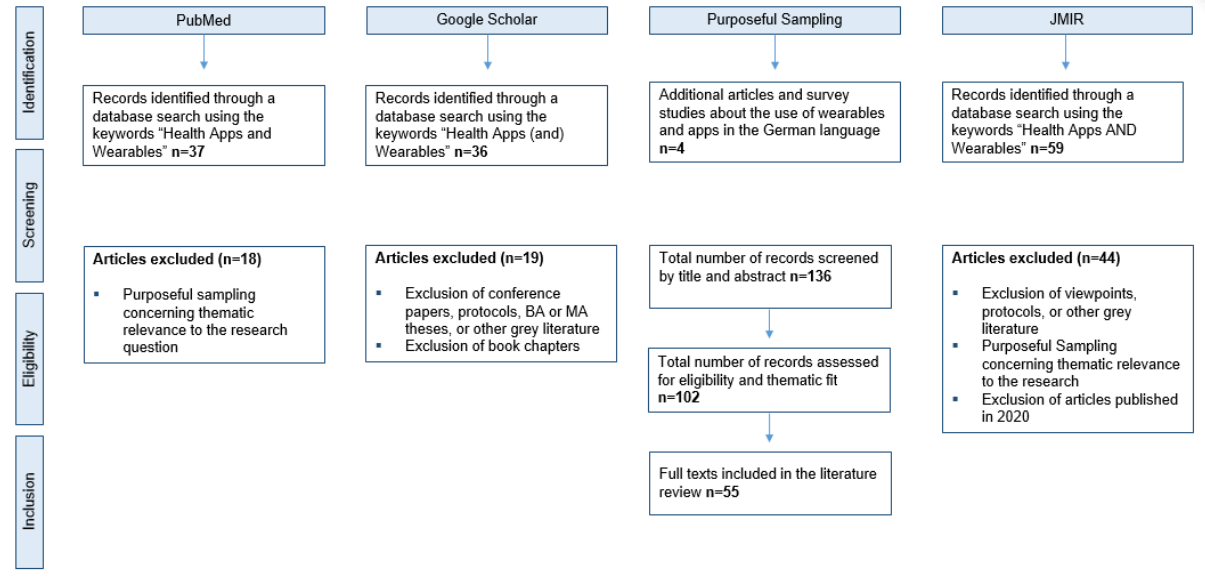
Figure 1. Scoping process for literature about health apps and